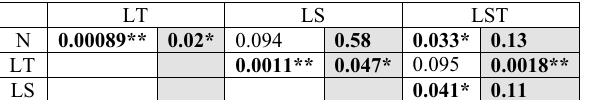
Table 4. Post-hoc permutation tests of the data from Final Test 2. Data were tested in two versions: raw data and normalized data (grey fields). Stars indicate significance after Bonferroni-Holm correction for the number of orthogonal tests with p < 0.05* and p <